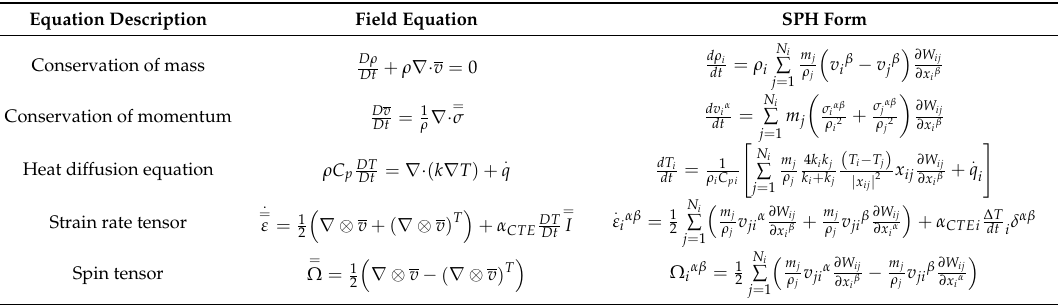
Table 1. Field equations and their SPH formulation.